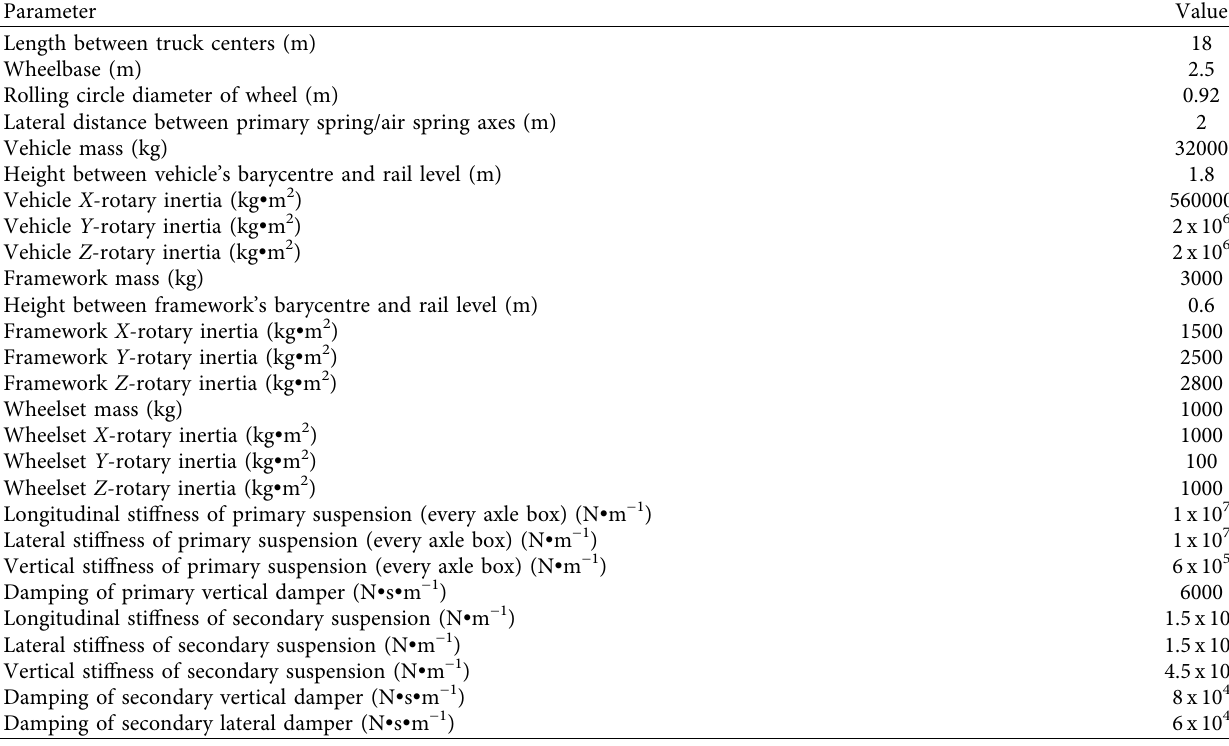
Table 2: Dynamic parameters of the vehicle.